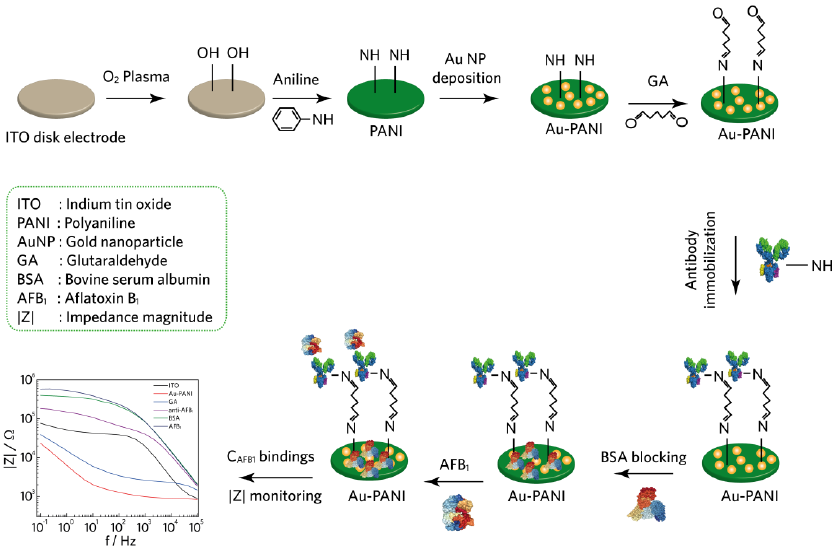
Figure 1. Schematic diagram showing a surface modification of Au – PANI-based disk electrodes for Aflatoxin B 1 binding with glutaraldehyde (GA) acting as a crosslinking agent to bind anti-AFB 1 to polyaniline (PANI) nanofibers.